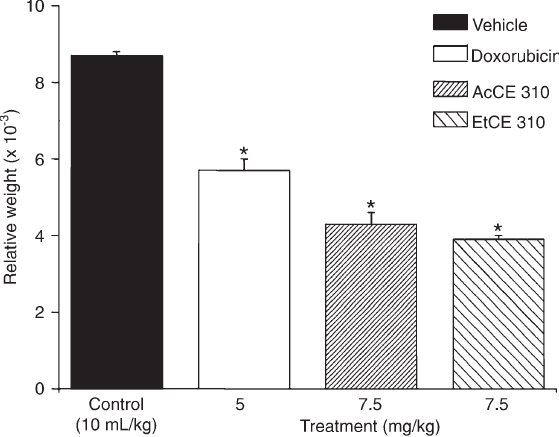
Figure 1. Effect of AcCE 310 and EtCE 310 on relative solid tumor weight (difference of weights of healthy leg and leg with tumor divided by body weight). Graph demonstrating relative tumor weight after a 15-day experimental period. Treatments: control group (vehicle, 10 mL/kg), doxorubicin (5 mg/kg), AcCE 310 and EtCE 310 extracts (7.5 mg/kg), given every 3 days, ip , for 15 days. Data are reported as means ± SEM for 8 to 10 animals per experimental group. AcCE = acetate crude extract; EtCE = ethanol crude extract. *P # 0.001 compared to control (ANOVA followed by the Duncan of tumor relative weight of 50.3 and 54.6% (P # 0.001), respectively, compared to the control group (Figure 1).